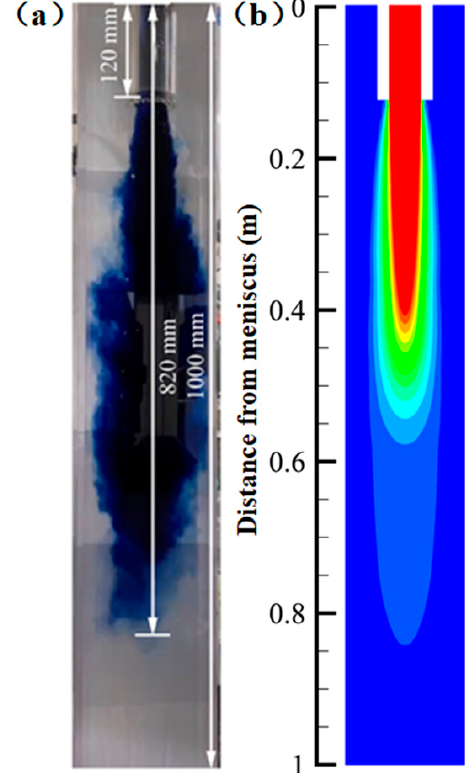
Figure 3. Simulated and water-mode flow field distribution ( a ) water-mode results, ( b ) numerical simulation results.